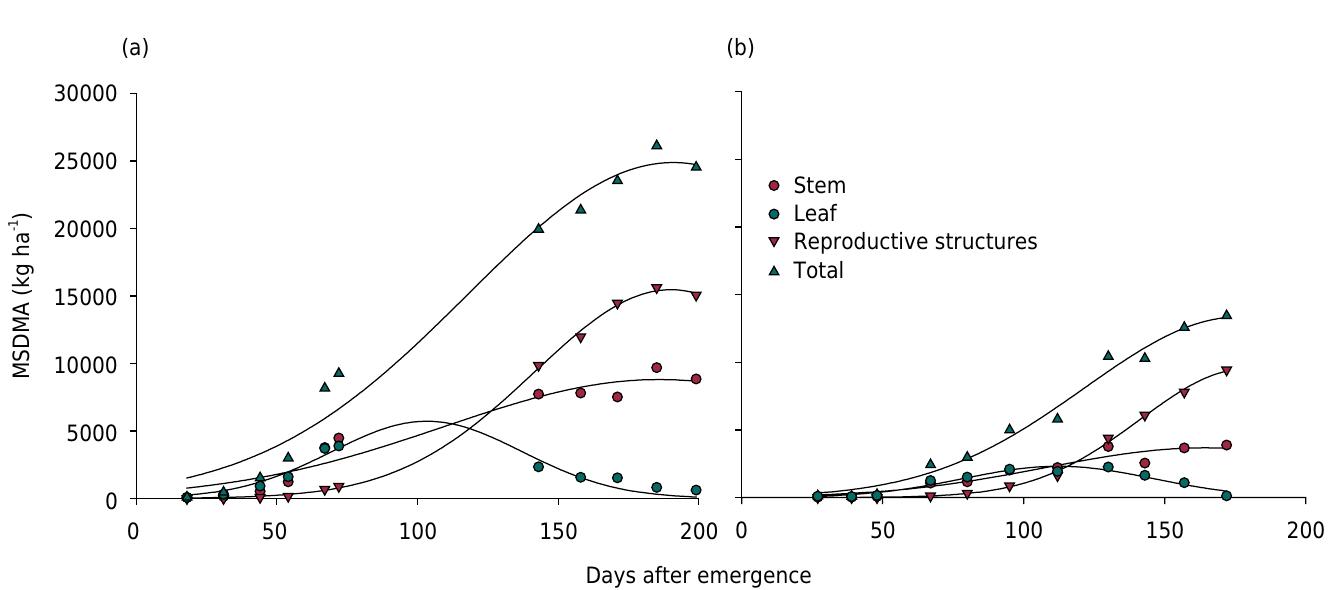
Figure 2. Accumulation of above ground dry matter (MSDMA) in the study sites in the states of Bahia (a) and Mato Grosso (b), Brazil. Results represent the average of three varieties in Bahia and two varieties in Mato Grosso.